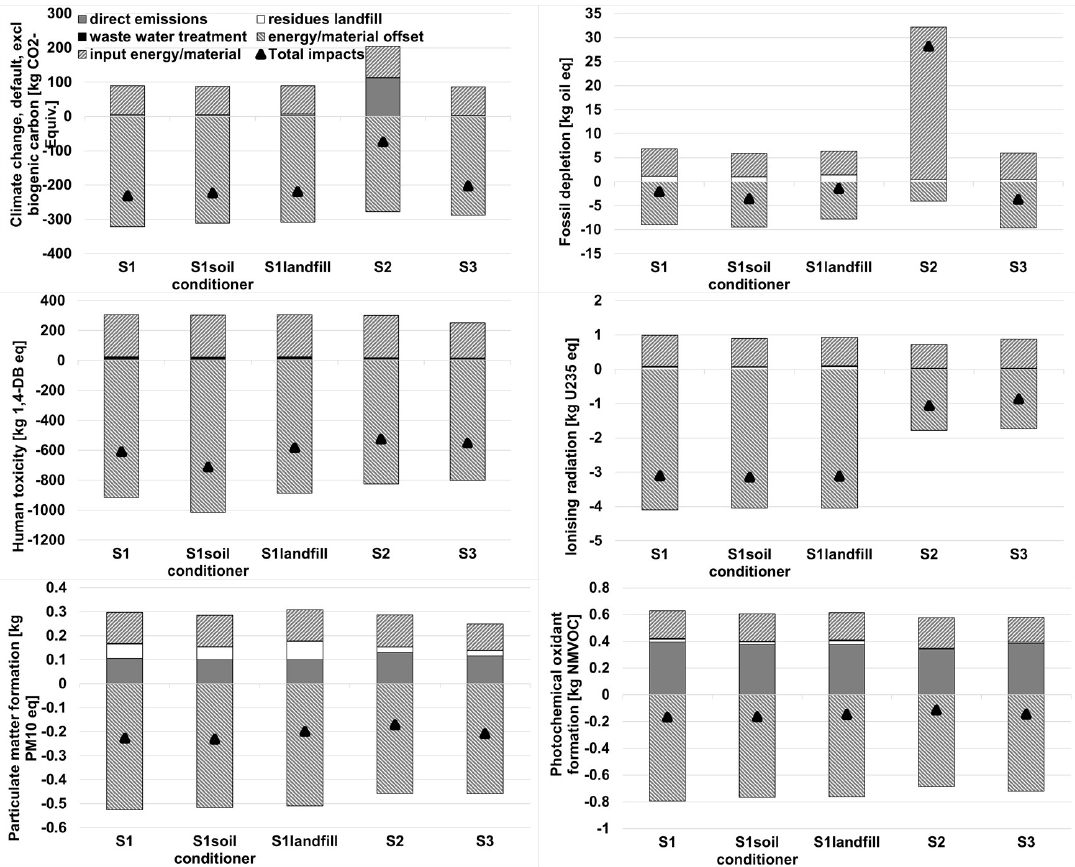
Figure 4. Characterized environmental impacts of the considered systems.